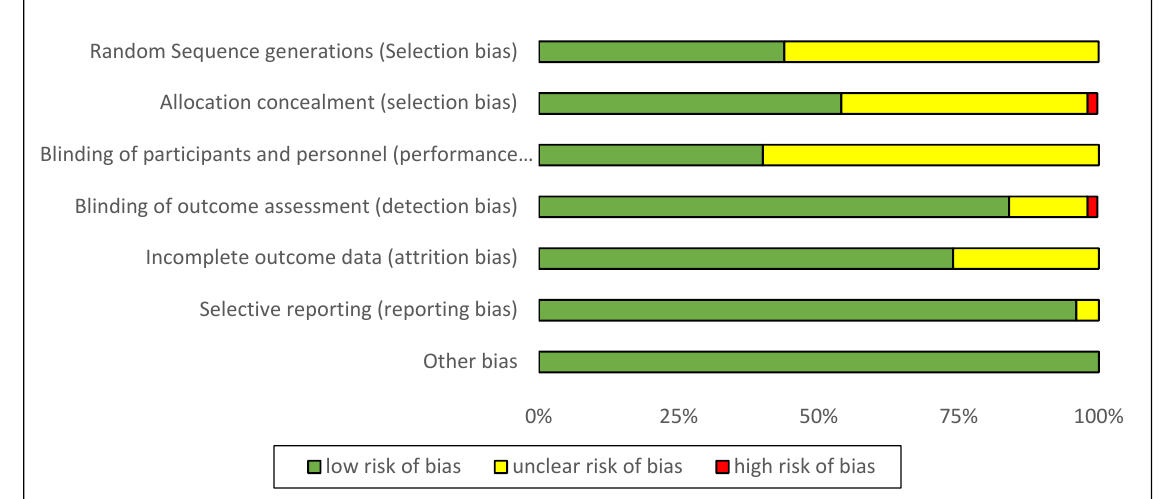
Figure 3. The result of the risk of bias assessment: each risk of bias item is shown as percentages across all included studies.